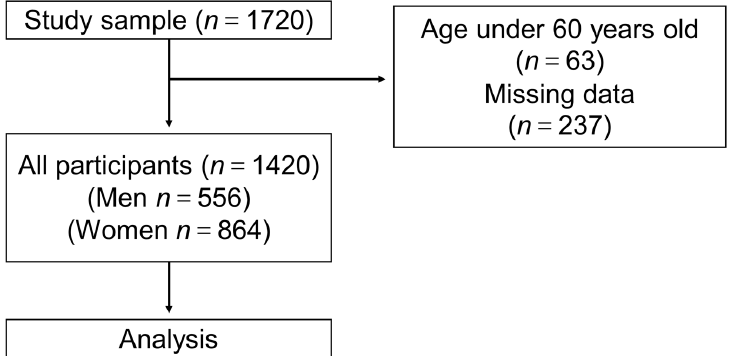
Figure 1. Study flow. Flow diagram of 1420 elderly people who were included in the current study from the Shimane CoHRE study. A detailed explanation is described in Section